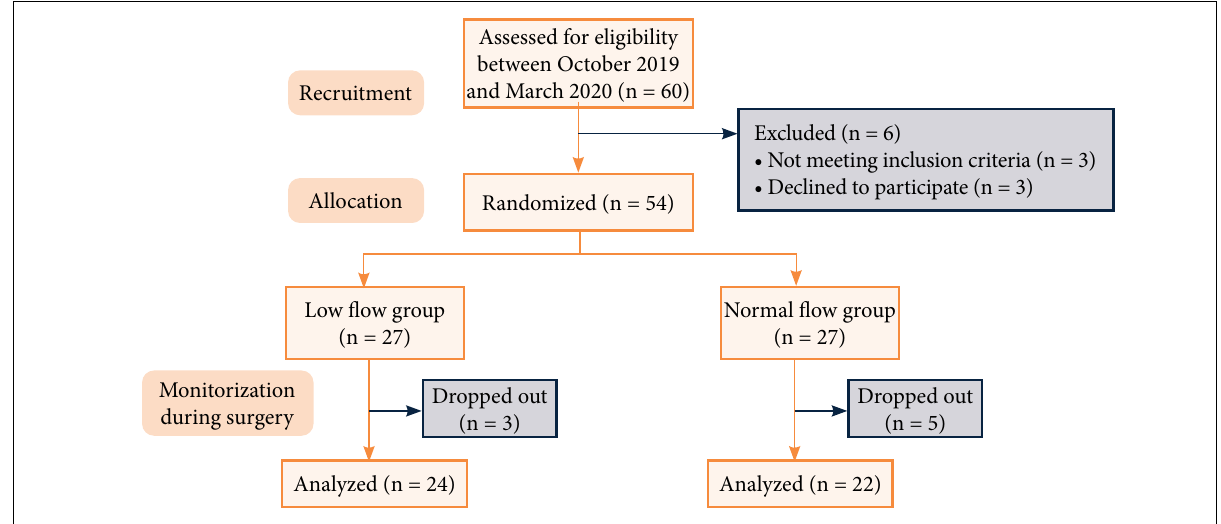
Figure 1 – CONSORT flow